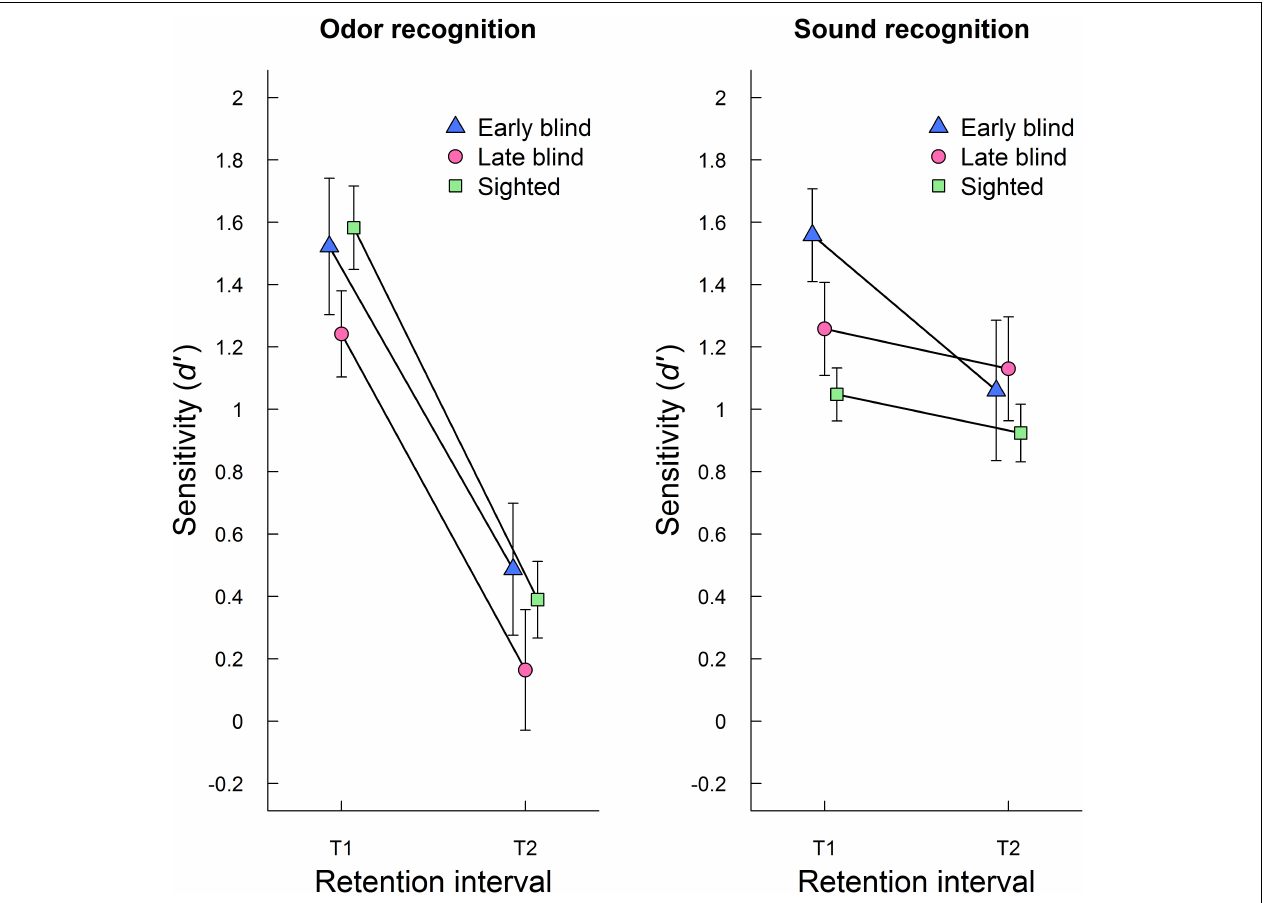
FIGURE 1 | Aggregated episodic recognition performance (mean d (cid:48) ± SE) for odors (left panel) and sounds (right panel) at initial testing (T1) and follow-up (T2) is plotted separately for early blind, late blind, and sighted